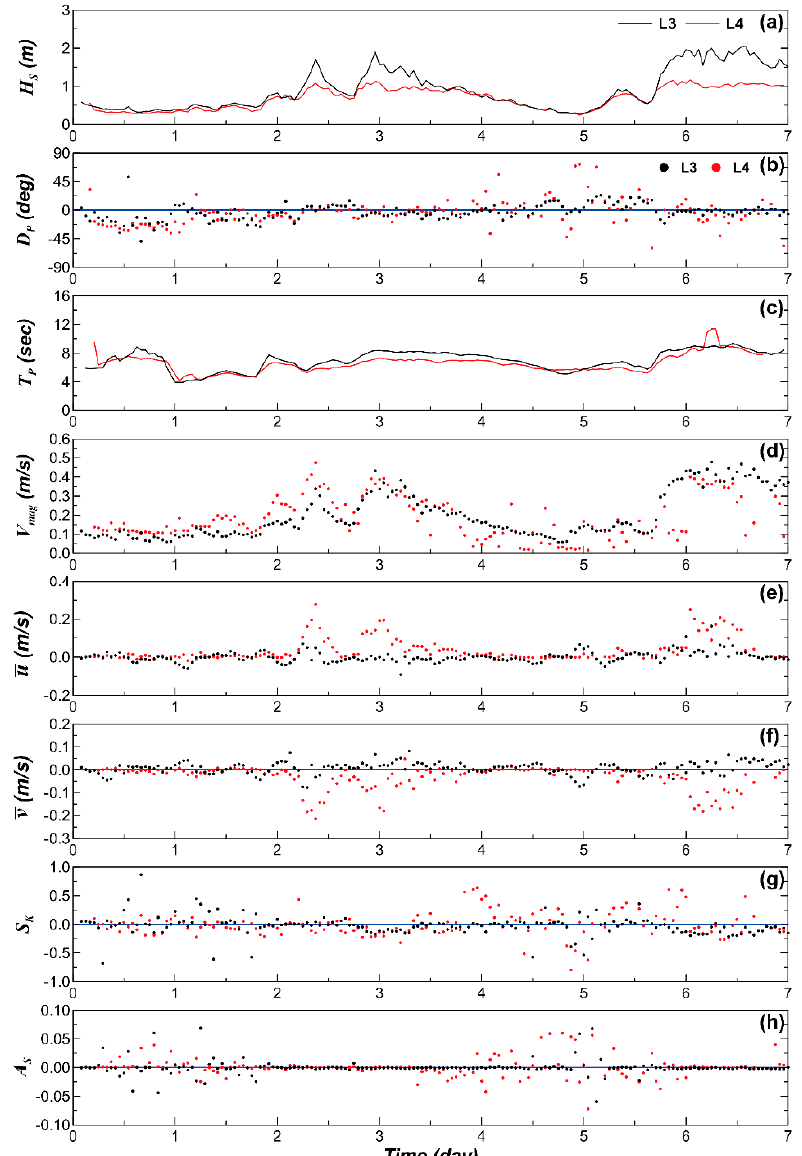
Figure 6. Wave and hydrodynamic parameters from 21–28 December 2018 of Exp#2. ( a ) H s : significant wave height, ( b ) D p : peak wave direction, ( c ) T p : peak wave period, ( d ) V mag : velocity magnitude, ( e ) u : cross-shore velocity ( + onshore), ( f ) v : longshore velocity ( + NW, left in the figure), ( g ) S k : wave skewness, ( h ) A s : wave asymmetry.